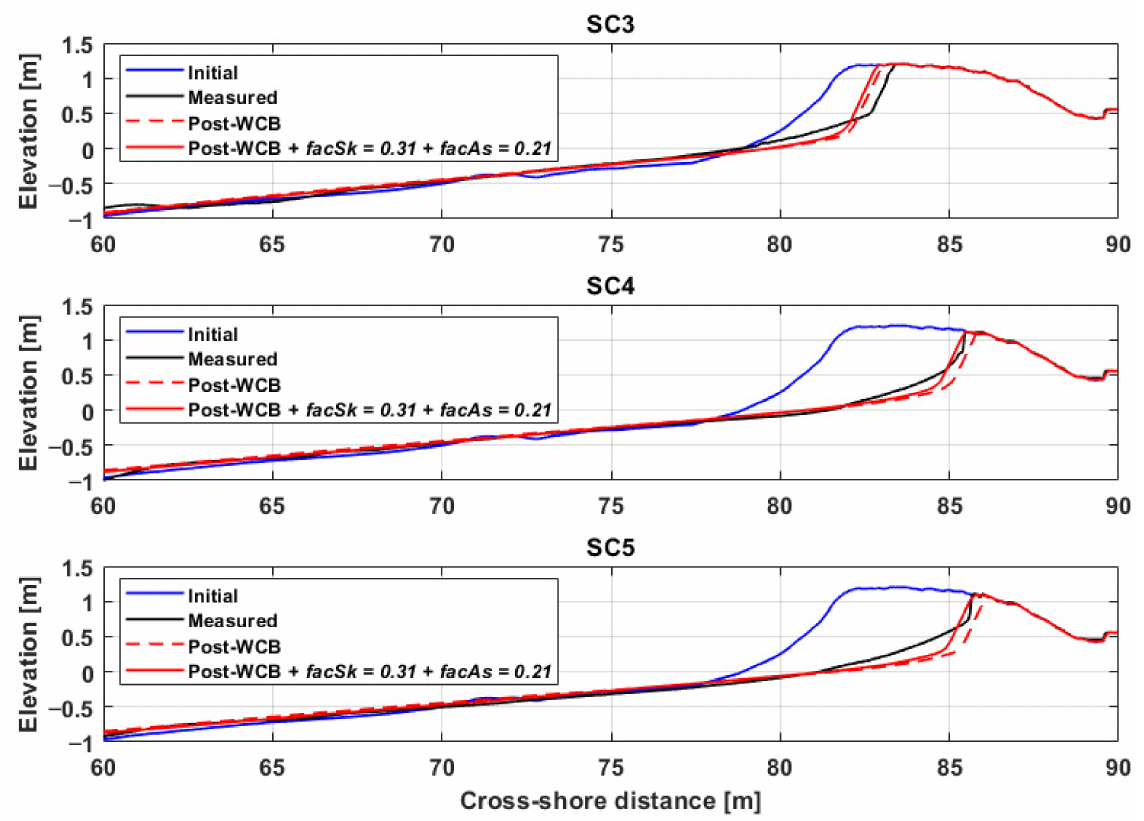
Figure 6. Comparison of initial, measured and computed final profiles applied to wave calibration (WCB) and wave shape calibration ( facSK = 0.31 and facAs = 0.21) for SC3, SC4, and